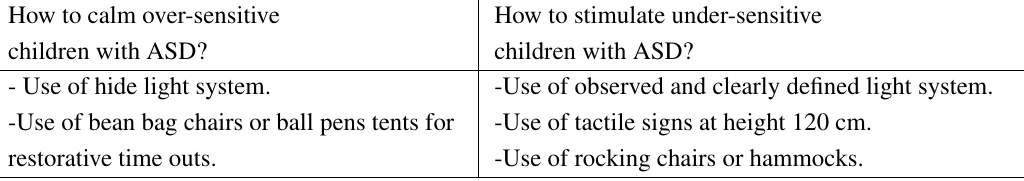
Table 18. How to use site furniture in creating specific influences (Wilson, 2006)